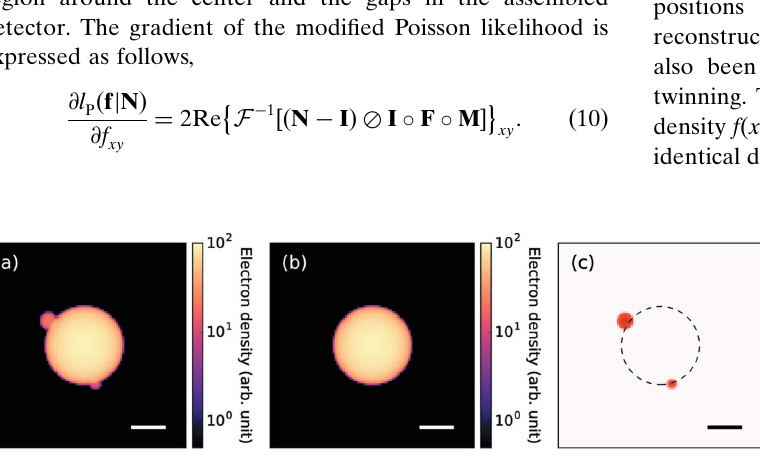
Figure 2 The object used in the simulation of the structure reconstruction. ( a ) 2D projected electron density of the object. ( b ) 2D projection of a uniform sphere used as the initial structure in structure optimization. ( c ) Difference between ( a ) and ( b ) defined as ( a ) (cid:4) ( b ). The scale bars are 100